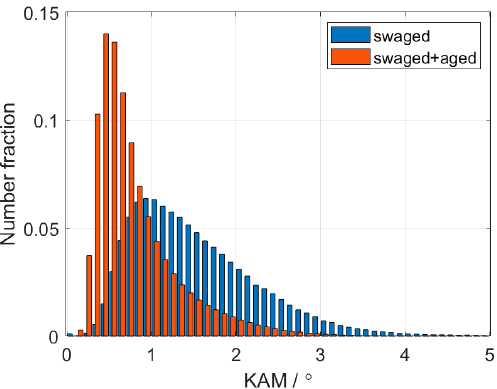
Figure 9. KAM distributions of the swaged and swaged + aged samples.